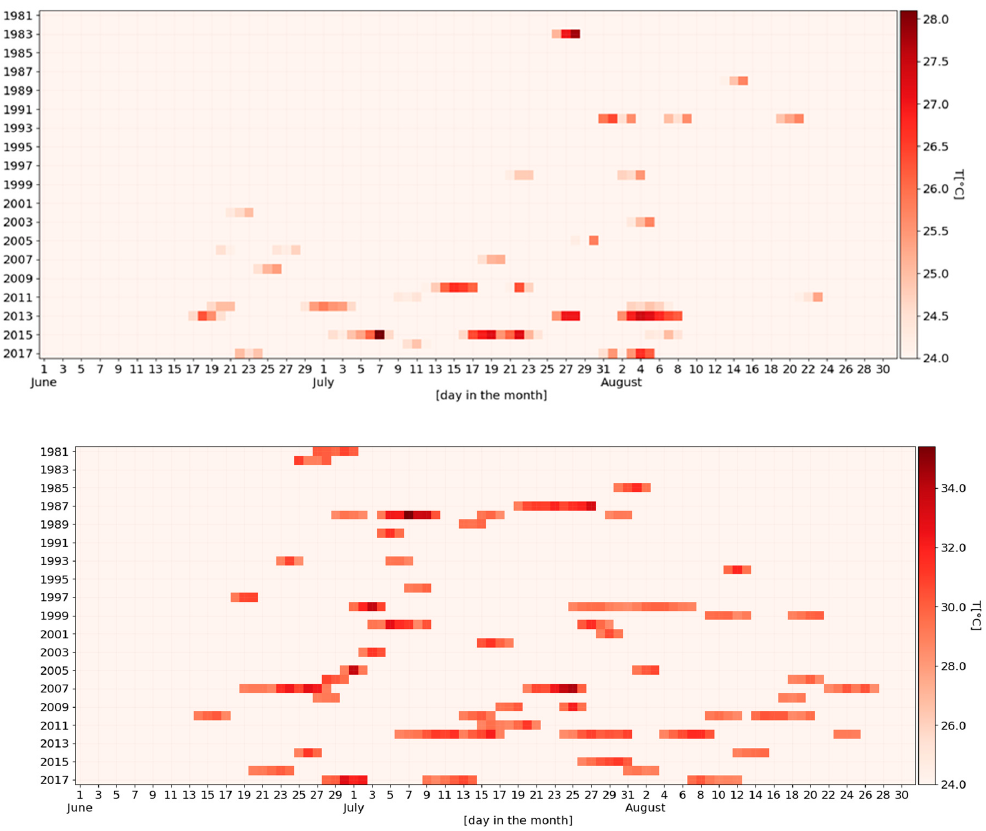
Figure 1. A daily overview of heat waves and their intensity in the period 1981–2017 in Brnik (Slovenia; top) and Larisa (Greece; bottom) from 1 June to 31 August. Only days in heat waves are colored, darker red designating higher daily mean air temperatures. Int. J. Environ. Res. Public Health 2019 , 16 , x